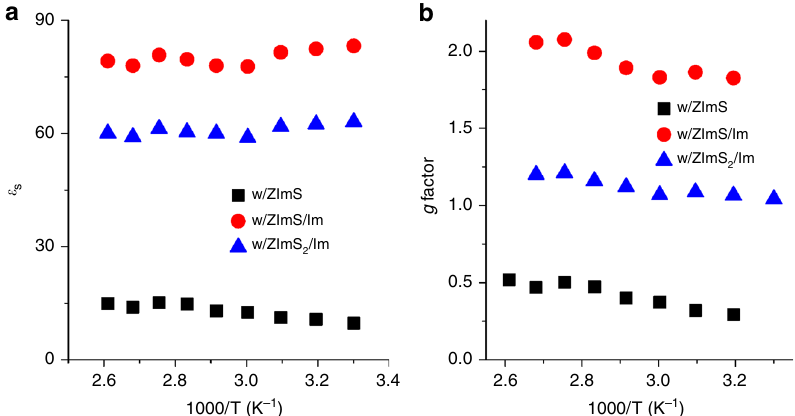
Fig. 6 Dielectric properties. a Static dielectric constant and b Kirkwood-Fröhlich g factor obtained for PSS:Im- b -PMB comprising additives, measured at different